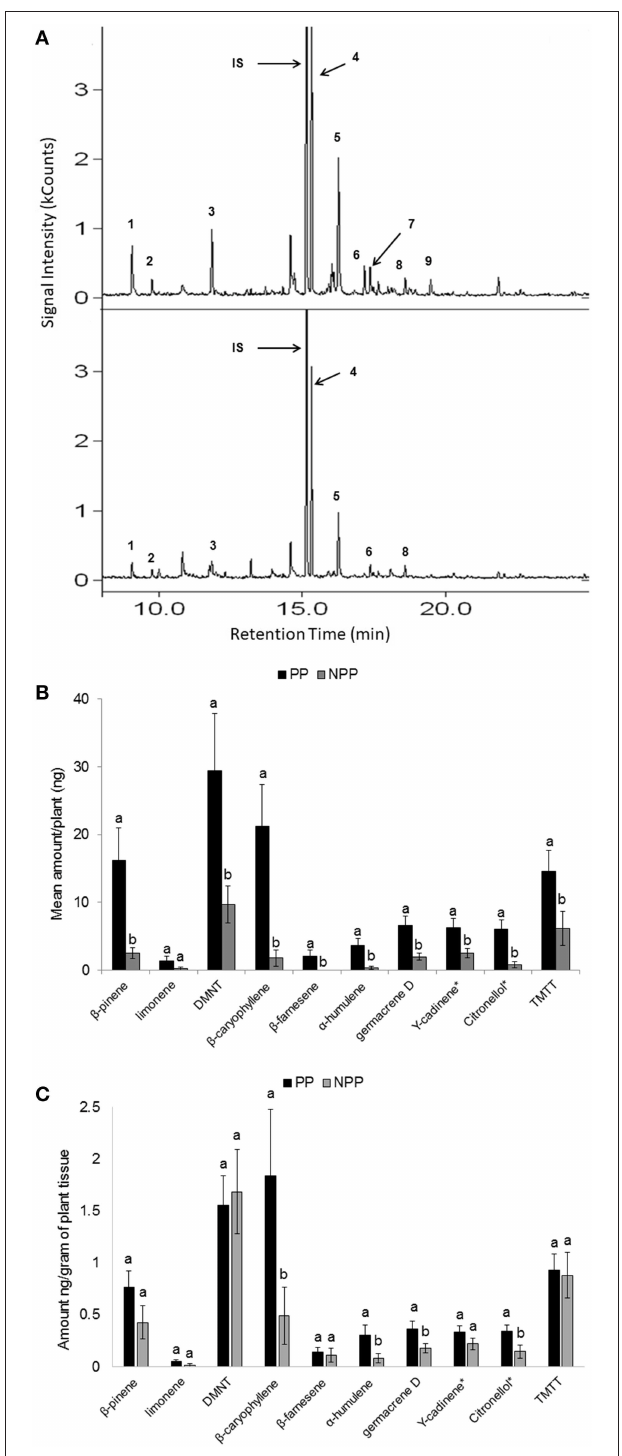
FIGURE 4 | Volatile compounds emitted by maize plants grown in soil obtained from Push-Pull (PP) companion cropping and Non-Push-Pull (NPP) monoculture fields: (A) Representative gas-chromatograph profiles of plants grown in soil from PP and NPP fields. Numbers designate key volatile compounds: 1. β -pinene, 2. limonene, 3. ( E )-4,8-dimethyl-1,3,7-nonatriene